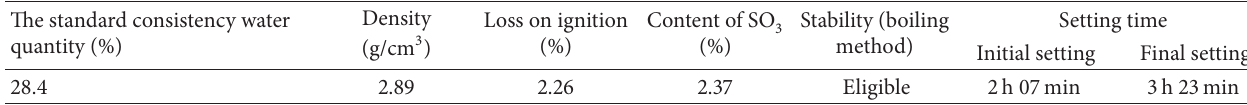
Table 2: The physical properties of